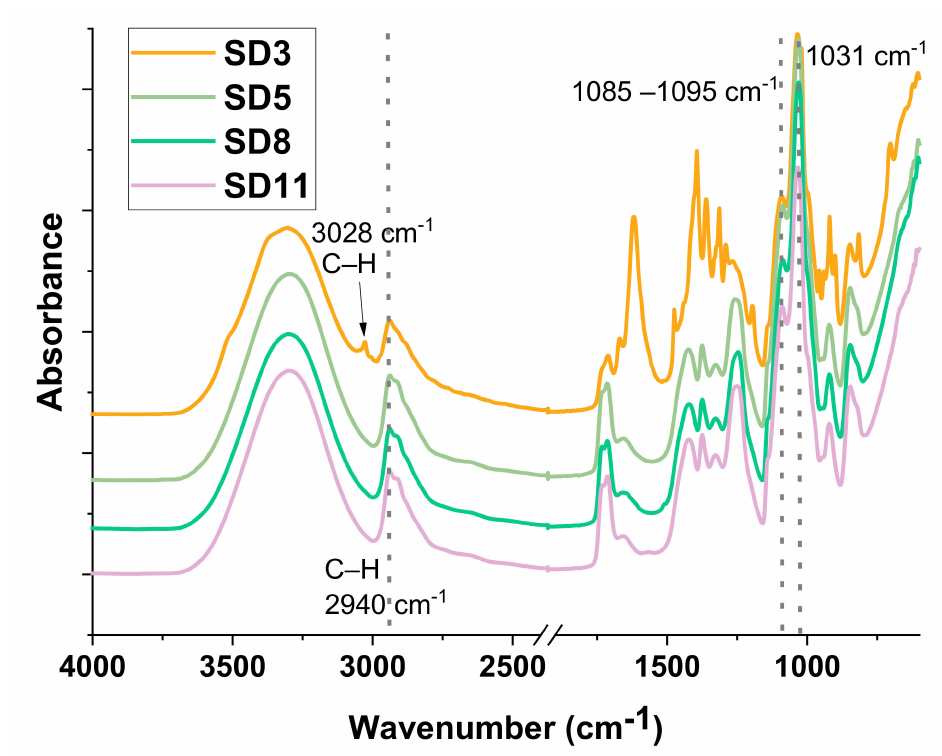
Figure 3. FT-IR spectra of the polymer films (SD3, SD5, SD8, and